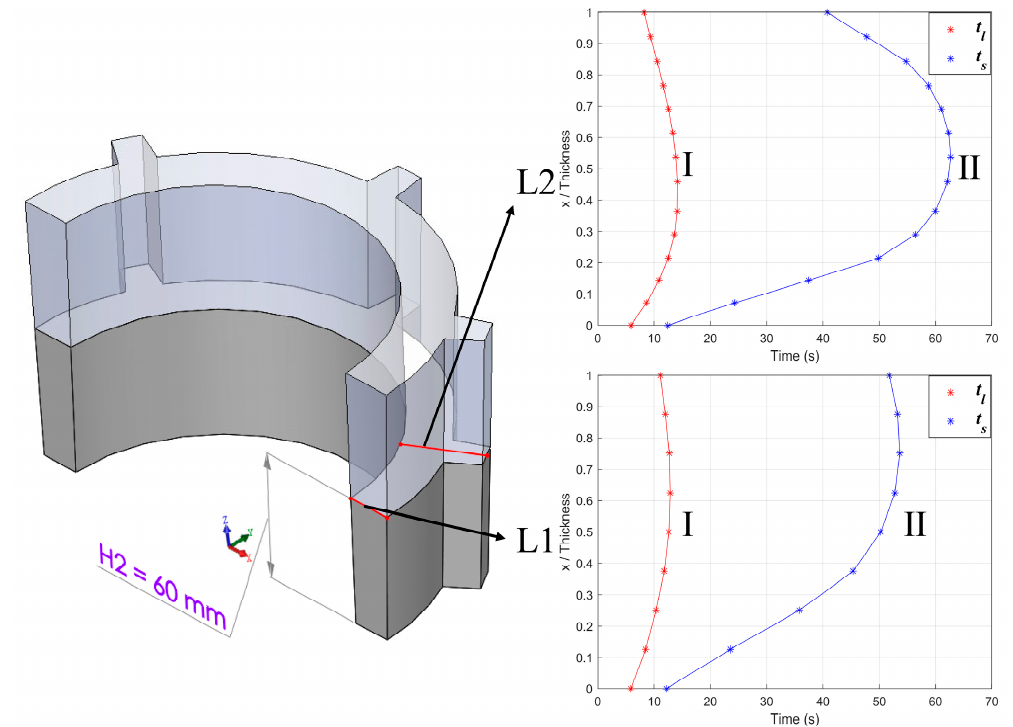
Figure 14. Dynamic solidification curves.